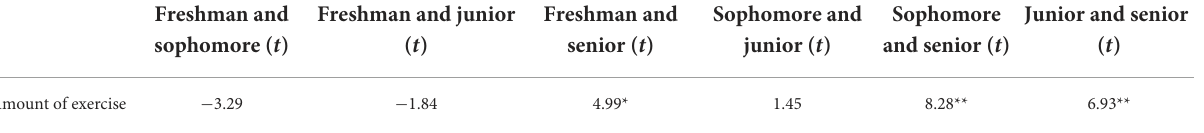
TABLE 4 Test for differences in exercise volume by